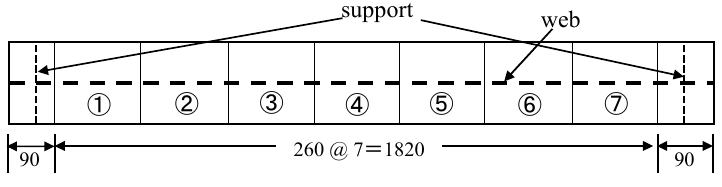
Figure 13. Lower flange area division (in mm).